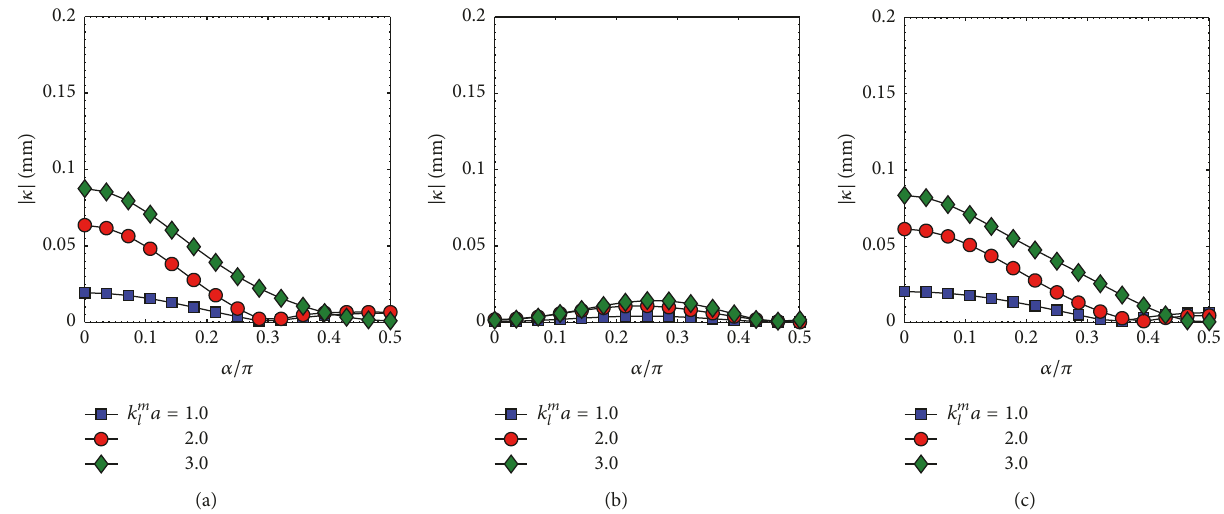
Figure 11: The sensitivity of 𝜎 𝑠 to (a) 𝐾 𝑛 and (b) 𝐾 𝑡 and (c) both 𝐾 𝑛 and 𝐾 𝑡 , under the P-wave incidence. 𝐾 𝑡 /𝐾 ∗ 𝑡 = 1 in (a), 𝐾 𝑛 /𝐾 ∗ 𝑛 = 1 in (b), and 𝐾 𝑛 /𝐾 ∗ 𝑛 = 𝐾 𝑡 /𝐾 ∗ 𝑡 in